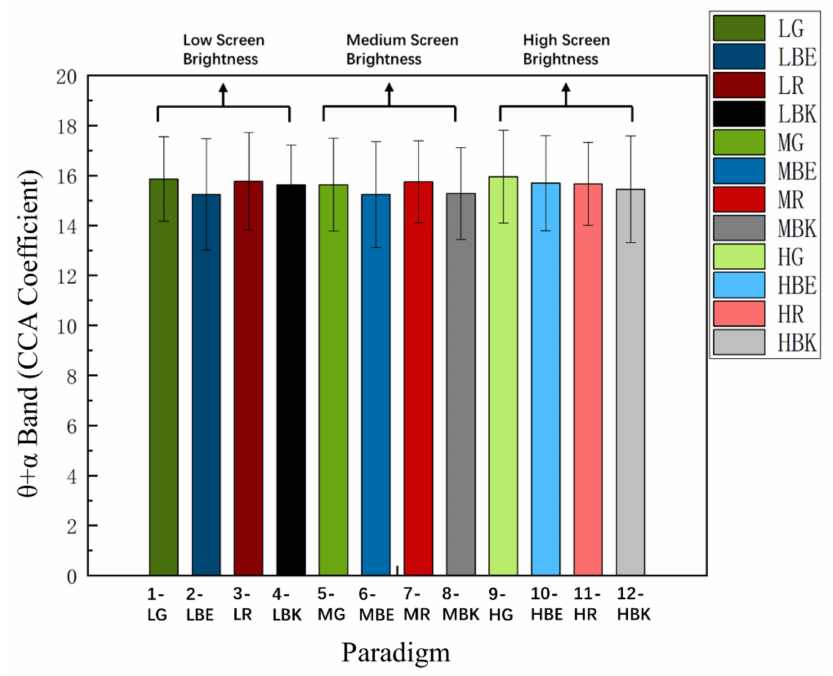
Figure 5. Comparison of the mean values and SD of θ + α band for 12 paradigms over 15 subjects. Statistics were assessed by one-way repeated-measures